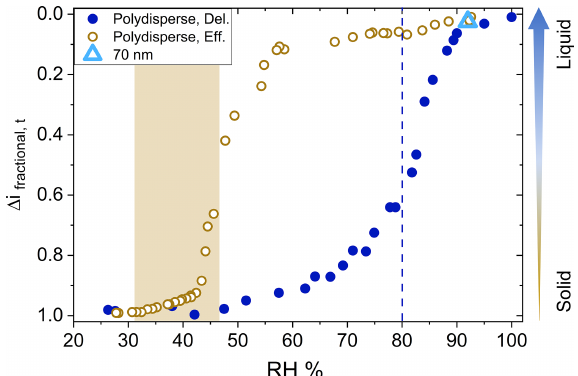
Figure 2. Efflorescence relative humidity (o) and deliquescence rel- ative humidity ( • ) curves for polydisperse (initial dry diameter num- ber GMD = 90nm, geometric standard deviation 1.7) ammonium sulfate (AS) aerosol. Shaded area and dashed line indicate litera- ture values for efflorescence and deliquescence, respectively. Parti- cle bounce for monodisperse 70nm (initial dry diameter) AS ( (cid:49) ) at 95% chamber RH also